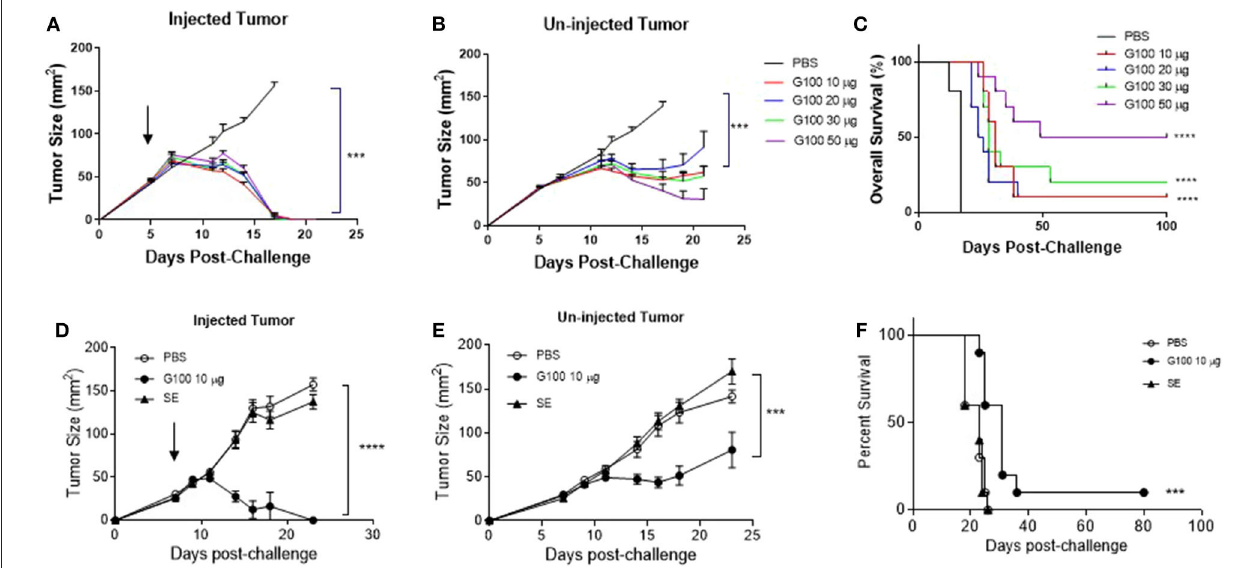
FIGURE 1 | G100 cures established murine A20 lymphomas and the anti-tumor effect depends on tumor cell TLR4 expression. (A,B) Tumor growth curves of G100-injected or contralateral un-injected A20 tumors. Five million A20 were implanted subcutaneously (s.c.) into Balb/c mice ( n = 5/group) on both flanks. Intratumoral (i.t.) injection of G100 (10, 20, 30, or 50 µ g GLA-SE) or PBS started on day 5 [indicated by the arrow on (A) ] when the tumors were palpable (average size ∼ 40 mm 2 ), three times per week, for a total of 9 injections. Mice were sacrificed when any tumor size reached over 150 mm 2 . (C) Survival curves in mice with bilateral A20 tumors treated with different doses of GLA-SE and PBS control. All the G100-treated mice (10, 20, 30, or 50 µ g GLA groups) had significant longer survival than control (PBS treated) mice ( p < 0.0001, adjusted p -values using Bonferroni method). The survival in the high dose (50 µ g GLA) G100 group was significantly better than that in low dose group (10 µ g) ( p = 0.03). (D,E) Tumor growth curves in mice treated with G100 and two controls, PBS and SE, for both (D) injected tumors, and (E) un-injected tumors. *** p < 0.001, **** p < 0.0001 based on tumor size on day 18. There was no difference in growth kinetics between PBS and SE groups for both the injected and un-injected tumors. The arrow in (D) indicate treatment start time. (F) Survival curves in mice treated with both PBS and SE controls. *** p < 0.001 between G100 and SE or PBS. Again, there was no difference between SE and PBS.